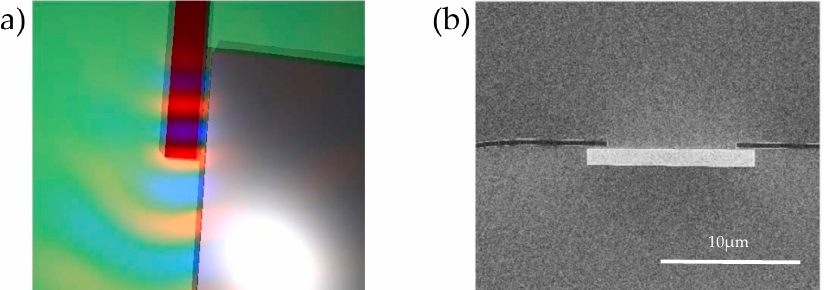
Figure 10. Directional coupling between silicon waveguides and a single interface plasmonic wave- guide. ( a ) A rendering of simulated field profile of the coupler. ( b ) An SEM image of the fabricated coupler. Figures reproduced from [149].